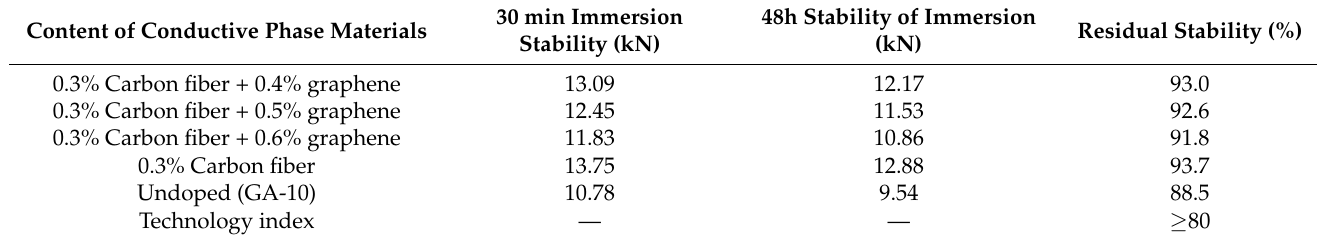
Table 14. Marshall test results of asphalt mixture